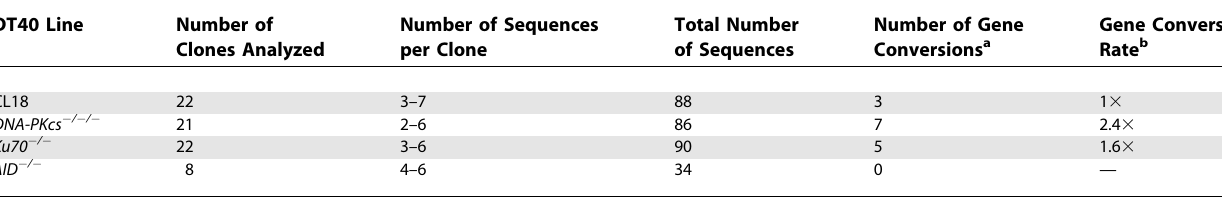
a Shown in Figure 2. b Relative to control CL18 cells. doi:10.1371/journal.pbio.0050080.t002 PLoS Biology |